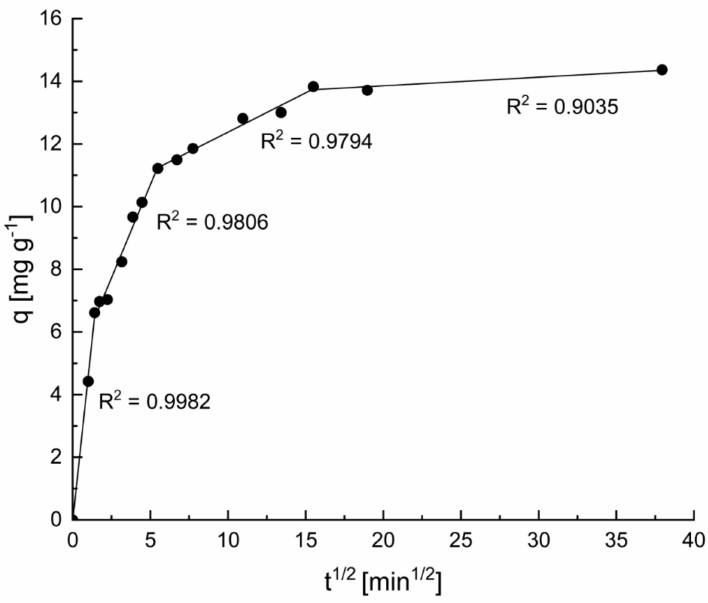
Figure 8. Weber–Morris intraparticle di ff usion model.